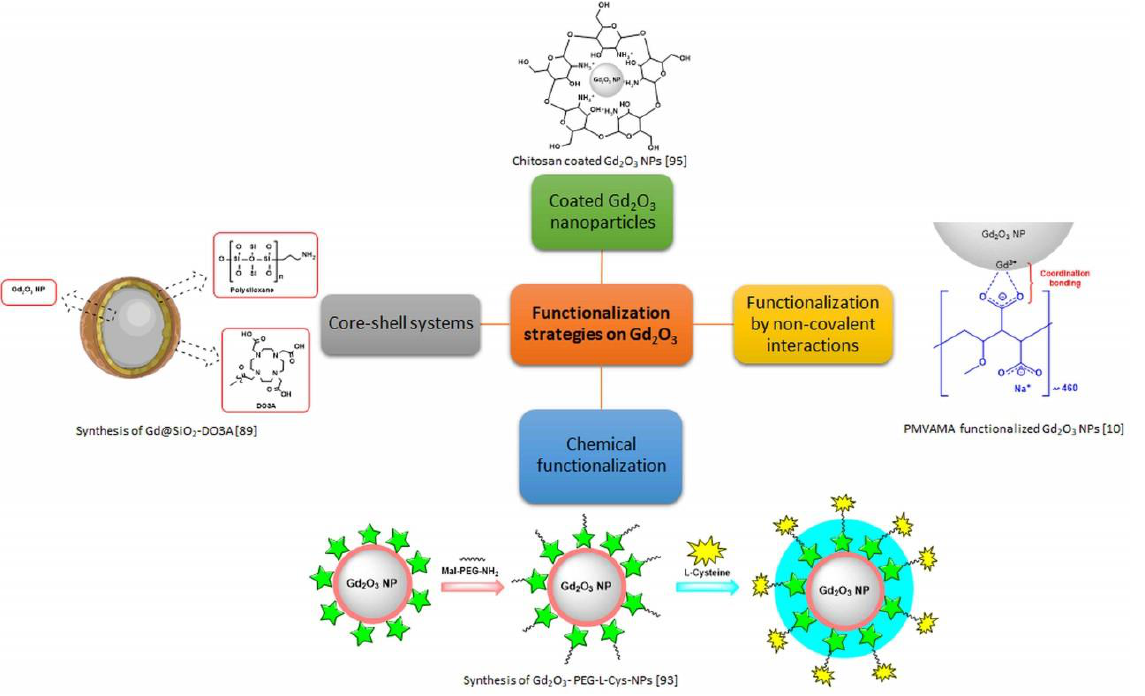
Figure 9. Functionalization strategies on gadolinium-based